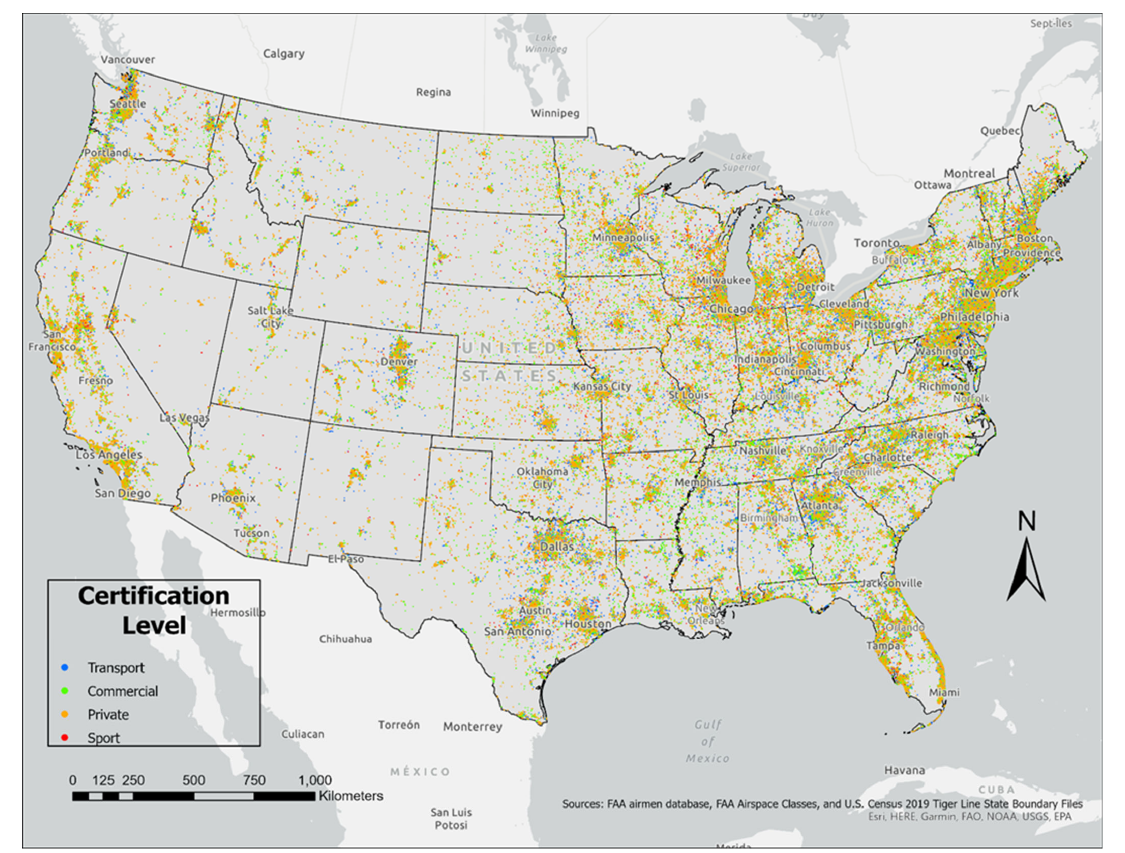
Figure 4. Geocoded point locations for FAA Registered Manned Pilots by certi fi cation level.